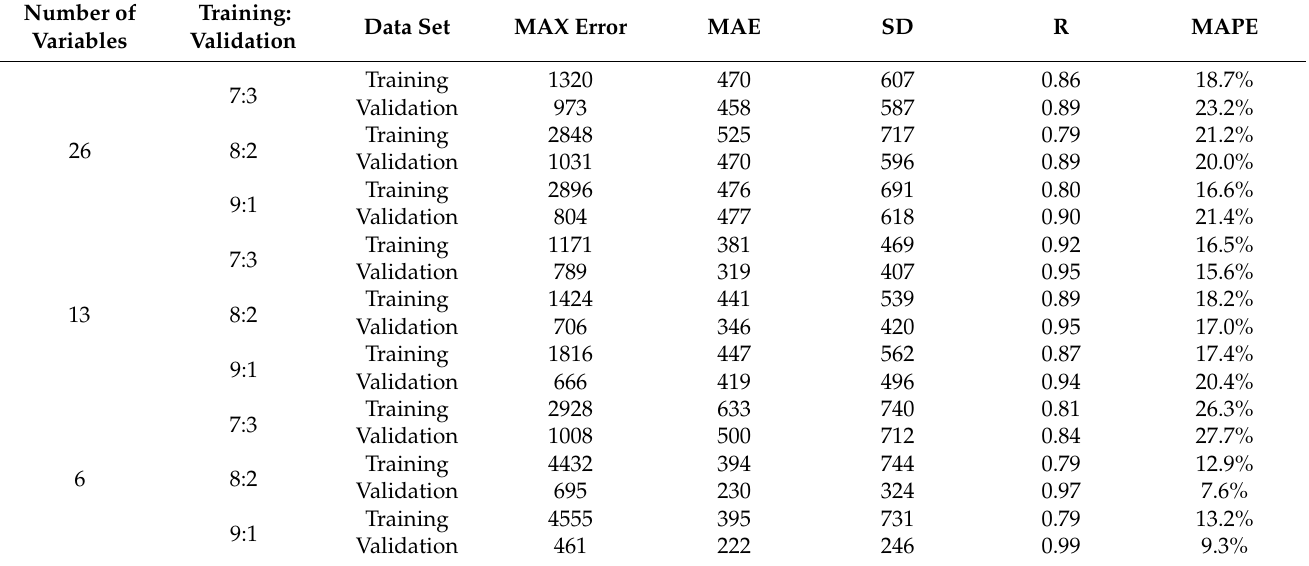
Table A13. Analysis of the results of RBFN model for natural gas consumption.